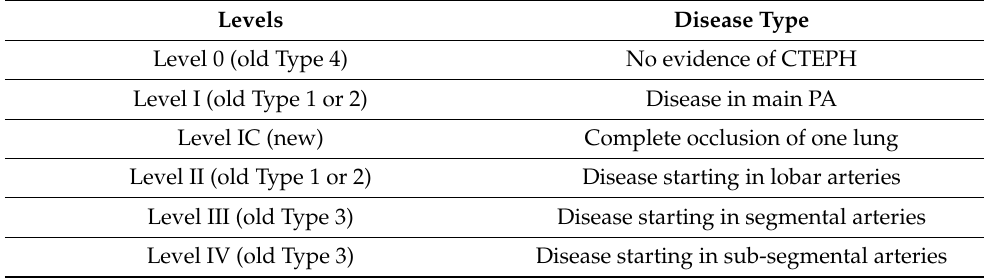
Table 1. New proposed UCSD classification.